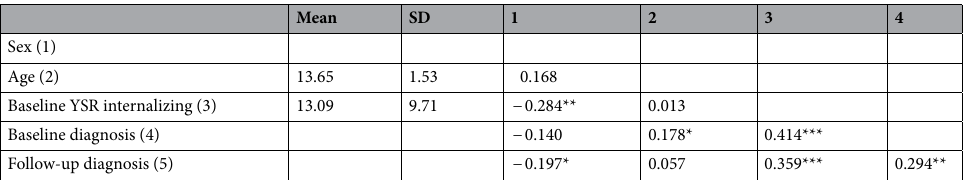
Table 3. Descriptive statistics and bivariate correlations of covariates in models. SD standard deviation. *Correlation significant at the p ≤ 0.05 (two-tailed). **Correlation significant at the p ≤ 0.01 (two-tailed). ***Correlation significant at the p ≤ 0.001 (two-tailed).